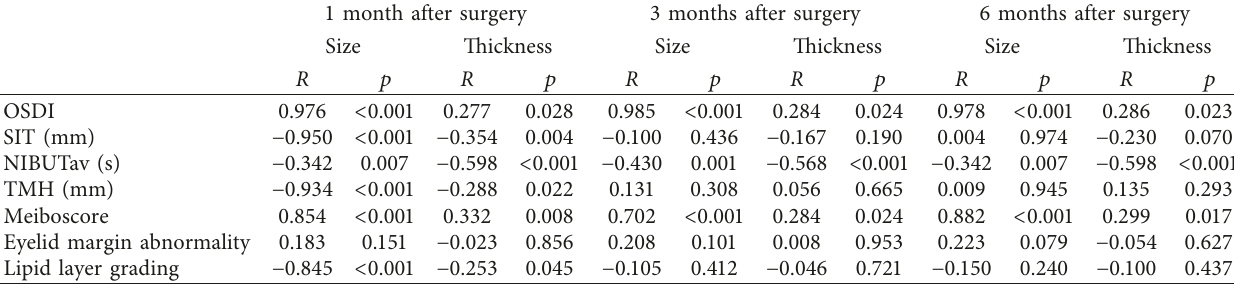
Table 4: Correlations between the pterygium parameters, dry eye indices, and MG functionality